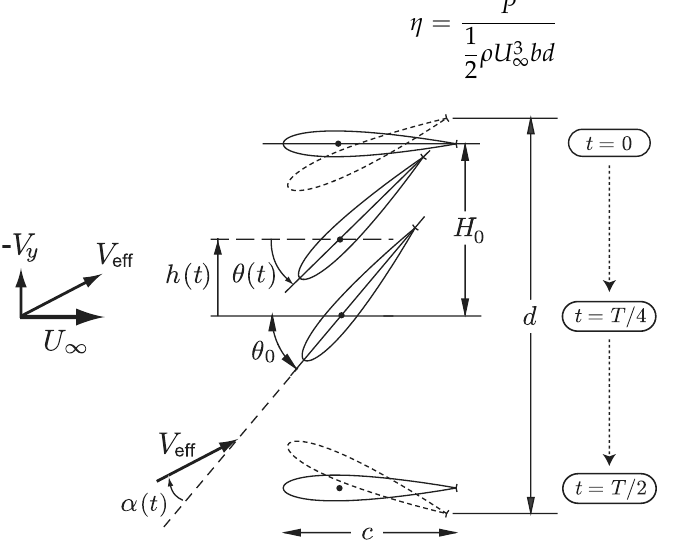
Figure 3. Representation of the kinematic parameters of the OFT equipped with a double GF (adapted with permission from Kinsey and Dumas